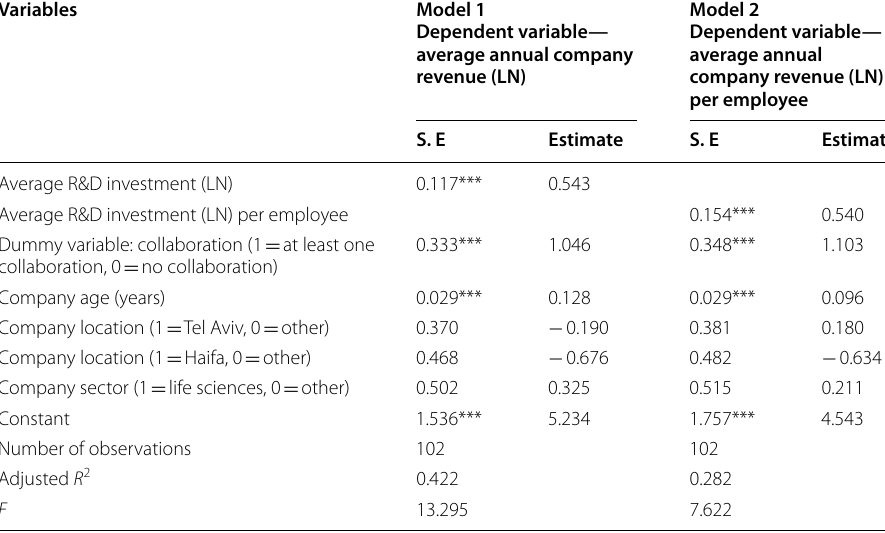
Table 2 Multiple regression model estimation results for evaluating the contribution of explanatory variables to